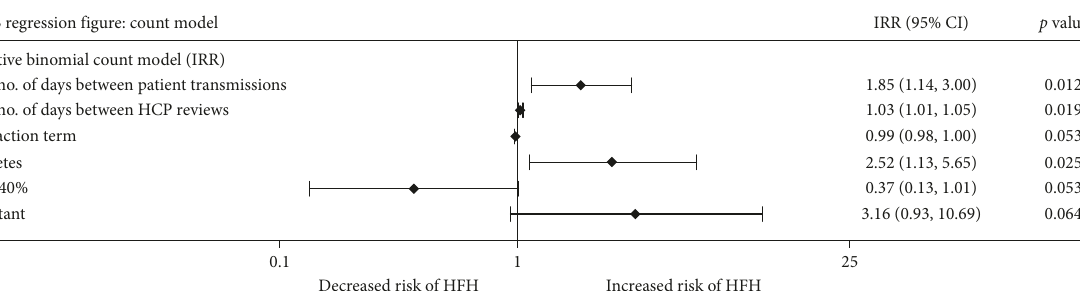
Figure 2: Forest plot illustration of the count model component of the zero-inflated negative binomial model. Regression coefficients and 95% confidence intervals are presented as incidence rate ratios. The interaction term is defined as the product of the average number of days between patient transmissions and the average number of days between health care provider reviews; it captures the synergistic impact of a patient’s stewardship and a health care provider’s stewardship of the CardioMEMS sensor. The constant term indicates the y -intercept of this model and can be interpreted as the number of days patients are predicted to spend in HFH if the value of all the independent variables could be set to zero. ZINB: zero-inflated negative binomial; IRR: incidence rate ratio; CI: confidence interval; Avg. no.: average number; EF: ejection fraction; HFH: heart failure